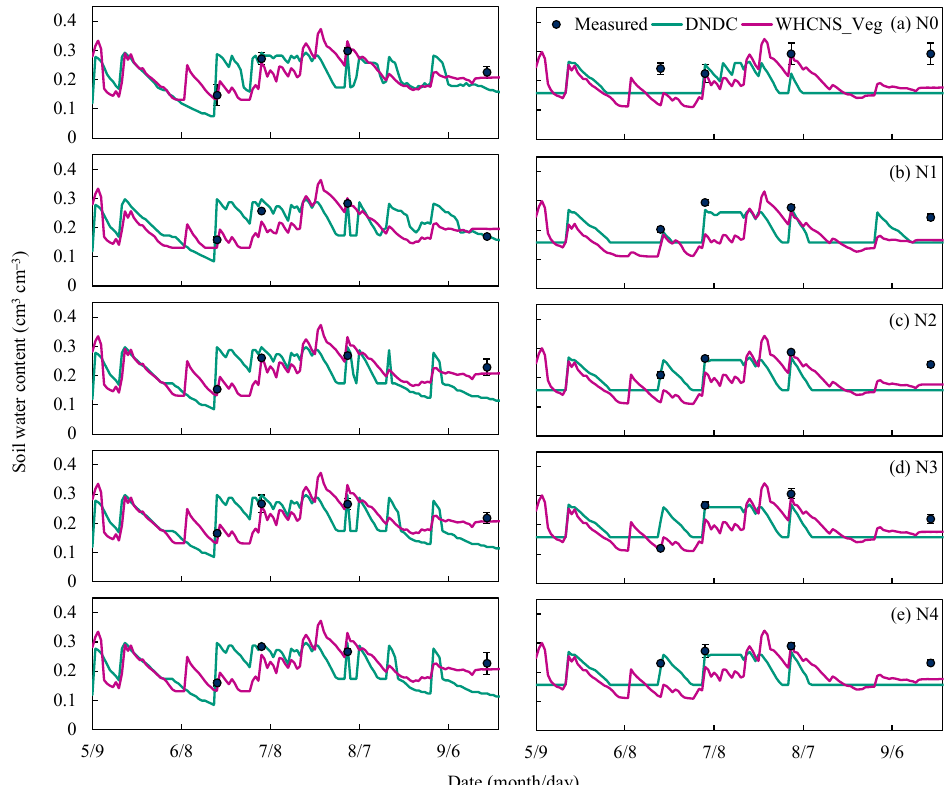
Figure 4. Daily simulated and measured soil moisture in the 0–0.2 m (the left of the figure) and 0.2–0.4 m (the right of the figure) in Wuchuan, China. ( a ) N0 treatment; ( b ) N1 treatment ( c ) N2 treatment ( d ) N3 treatment ( e ) N4 treatment. Vertical bars represent standard deviations ( n = 3).